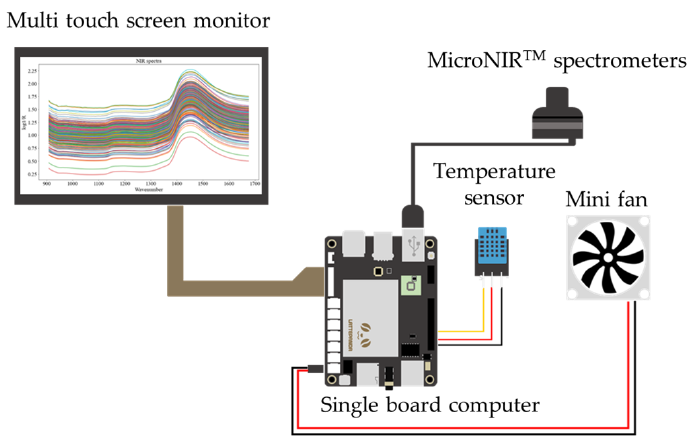
Figure 1. Schematic of portable NIR spectrometer.